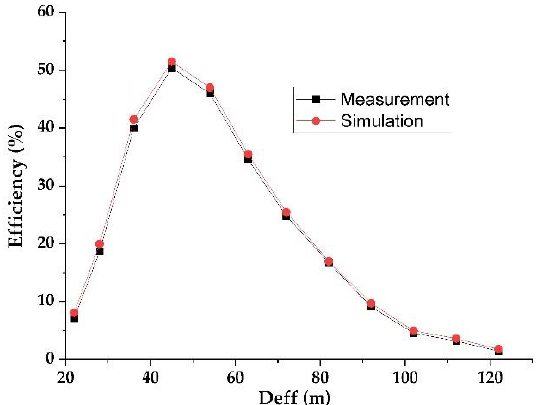
Figure 19. Measured and simulated DC output voltage as a function of the effective distance for 2 kΩ resistance load .